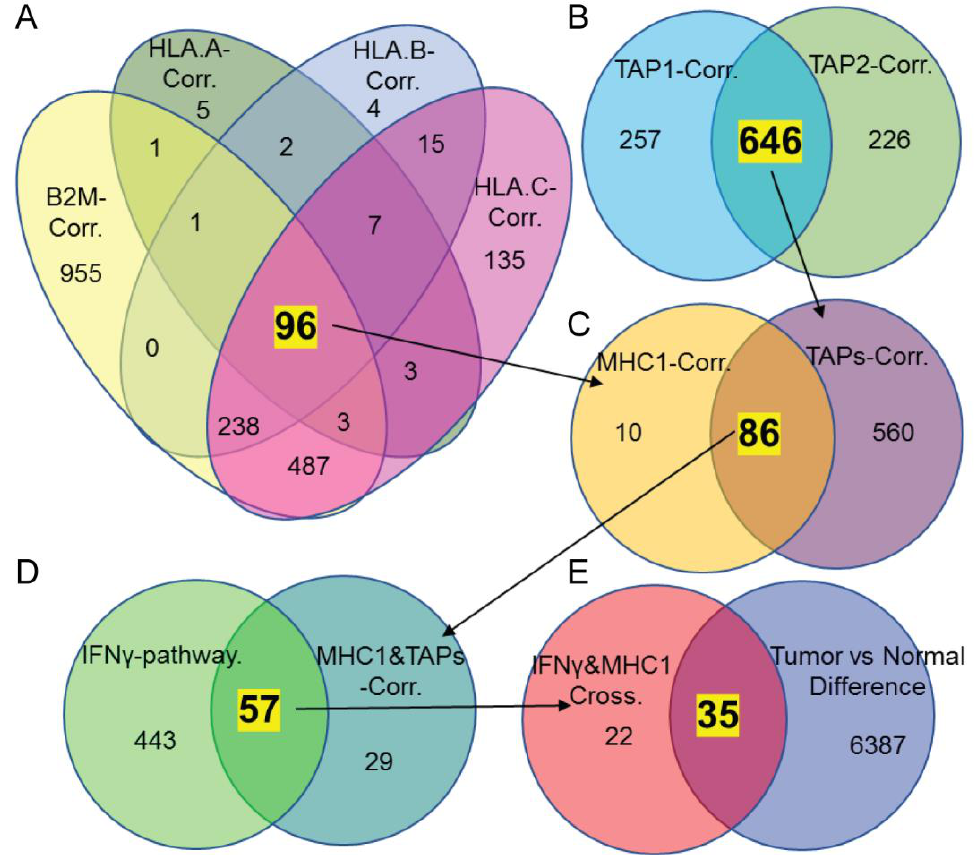
Figure 2. Potential candidates correlated with MHC-I expression. ( A ) Venn diagrams showing the commonly correlated genes for HLA-A , B , C , and B2M based on TCGA mRNA sequencing data of CRC ( r > 0.3, or ≤ 0.3, p < 0.05). ( B ) Venn diagrams showing the commonly correlated genes for TAP1 and TAP2 . ( C ) Venn diagrams showing the common correlated genes from ( A , B ). ( D ) Venn diagrams showing the common correlated genes analysis for MHC-I-related molecules and IFN- γ pathways. ( E ) Venn diagrams showing the common genes from ( D ) and differentially expressed molecules identified by the Proteogenomic Analysis of Human Colon Cancer study obtained from the study published in